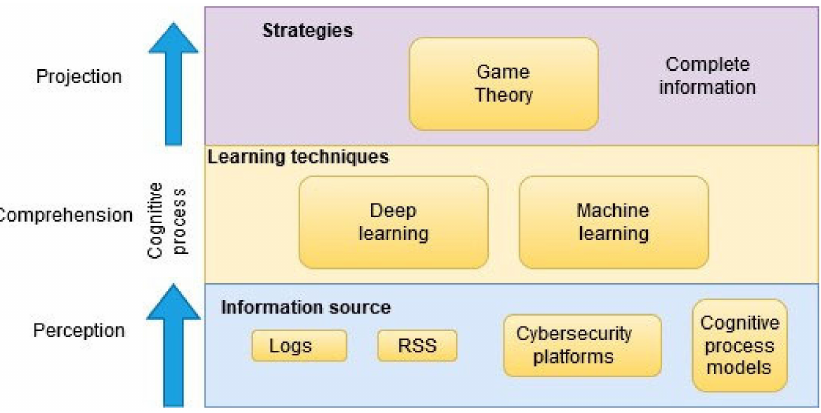
Figure 11. Proposal for a Cognitive Cybersecurity